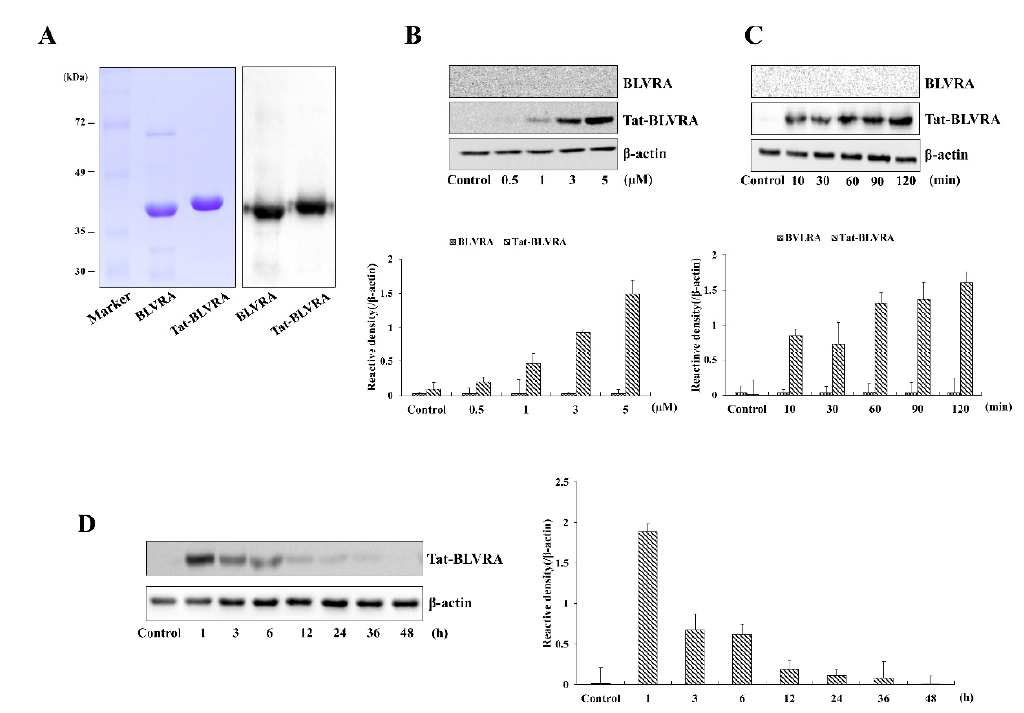
Figure 1. Purification and transduction of Tat-BLVRA protein. Purification of Tat-BLVRA and control BLVRA proteins. Purified proteins were analyzed by sodium dodecyl sulfate-polyacrylamide-gel electrophoresis (SDS-PAGE) and subjected to Western blot analysis with anti-Histidine antibody ( A ). Transduction of Tat-BLVRA proteins into HT-22 cells. Tat-BLVRA or control BLVRA (0.5–5 µ M) proteins were added to the culture medium for 2 h ( B ). Tat-BLVRA or control BLVRA (5 µ M) proteins were added to the culture medium for 10–120 min ( C ). Intracellular stability of transduced Tat-BLVRA ( D ). Cells were exposed to Tat-BLVRA (5 µ M) protein for 2 h and over various time periods. Then, the levels of Tat-BLVRA protein were measured by Western blotting and band intensity was assessed by densitometer. The bars in the figures represent the mean ± standard error of the mean (SEM) obtained from 3 independent experiments.